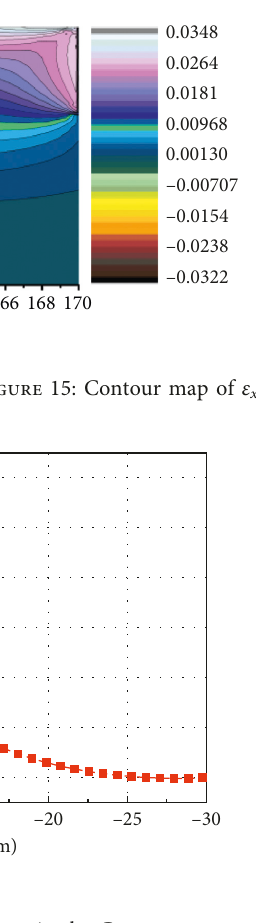
xx in the Ge mesa